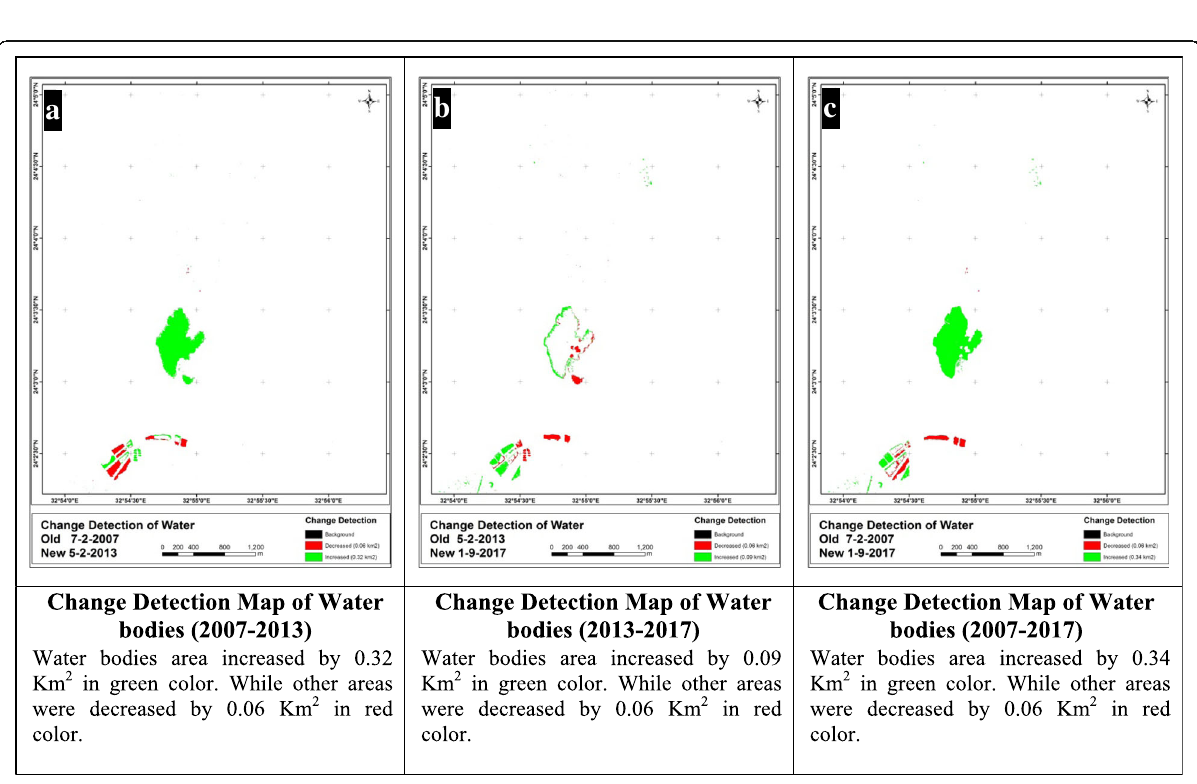
Fig. 12 Change detection of water bodies during the period of 2007-2017 in the study area a Change Detection Map of Water bodies (2007- 2013), b Change Detection Map of Water bodies (2013-2017) and c Change Detection Map of Water bodies